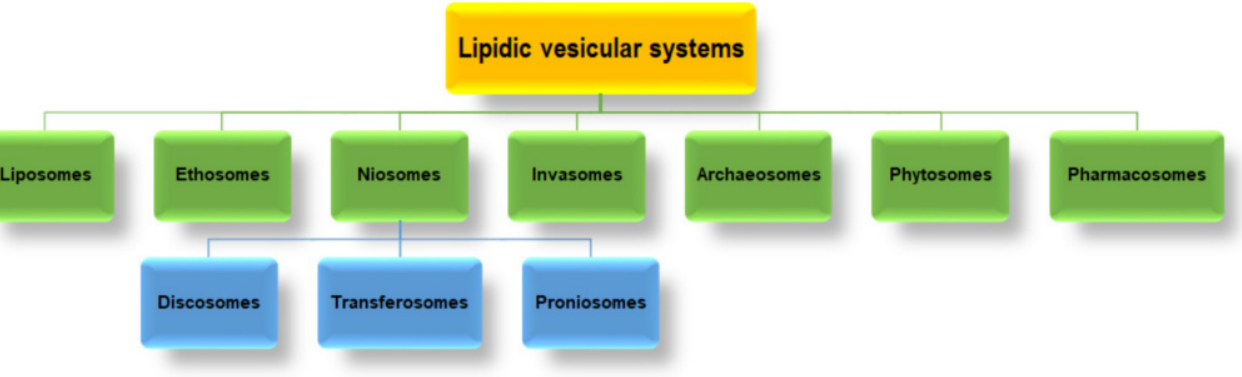
Figure 4. Examples of lipidic vesicular